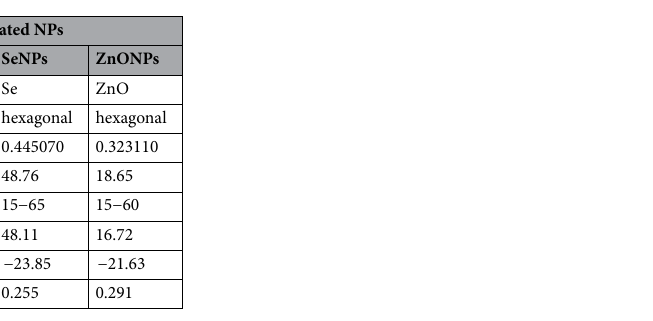
Table 1. Crystallographic data and DLS analysis of the myco-fabricated NPs. The mean crystallite size was calculated from the Scherrer equation. Average size, size distribution, zeta potential, and Polydispersity index were obtained from the DLS analysis as described in Materials and